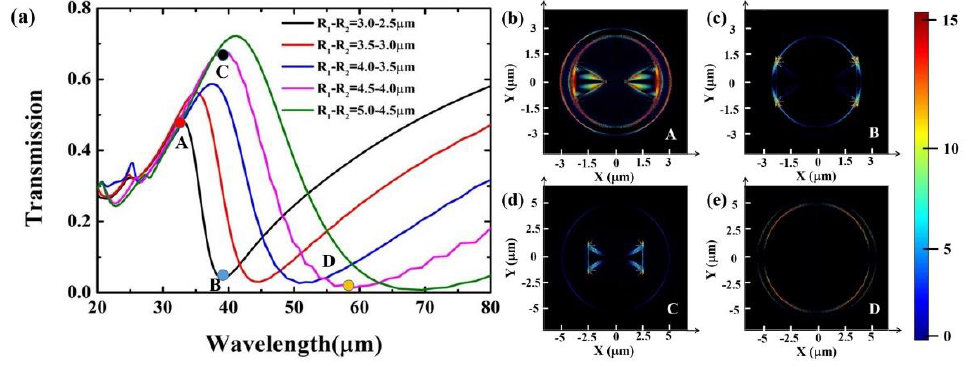
Figure 4. ( a ) Transmission spectra of the BP bowtie coupled with Au ring structure as a function of the inner and outer radius of the ring. The inner radius of Au ring ranges from 2.5 μm to 4.5 μm, and the outer radius of Au ring ranges from 3 μm to 5 μm. The Poynting vector distribution of the coupled structure in the X–Y plane at a wavelength of ( b ) 32.5 μm (resonance peak) and ( c ) 38.82 μm (resonance dip) when the inner and outer radius of the ring is 2.5μm and 3μm. The Poynting vector distribution of the coupled structure in the X–Y plane at a wavelength of ( d ) 38.82 μm (resonance peak) and ( e ) 58.67μm (resonance dip) when the inner and outer radius of the ring is 4 and 4.5 μm.